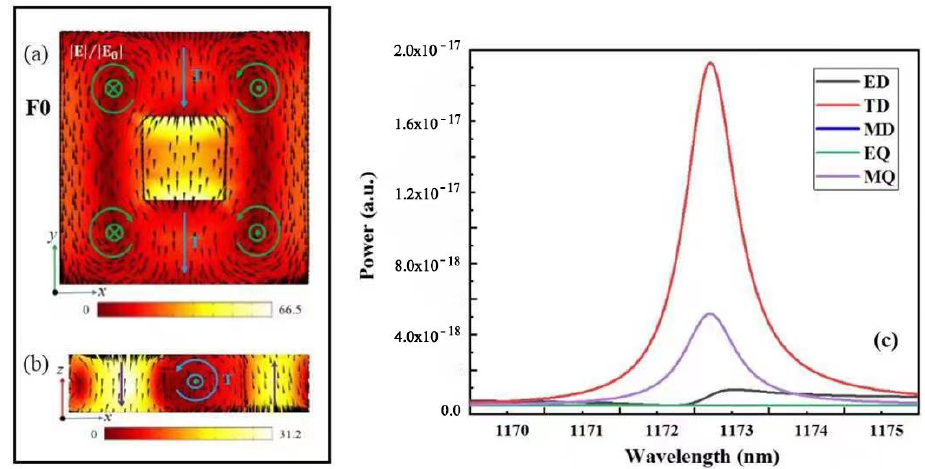
Figure 5. When g = 40 nm, the SHND nanostructure is symmetric. ( a ) Electric field enhancement and electric field vector distribution of F0 in the x–y plane. ( b ) Magnetic field enhancement and magnetic field vector distribution of F0 in the x–z plane. ( c ) Radiant energy of each multipole resonance mode at F0.